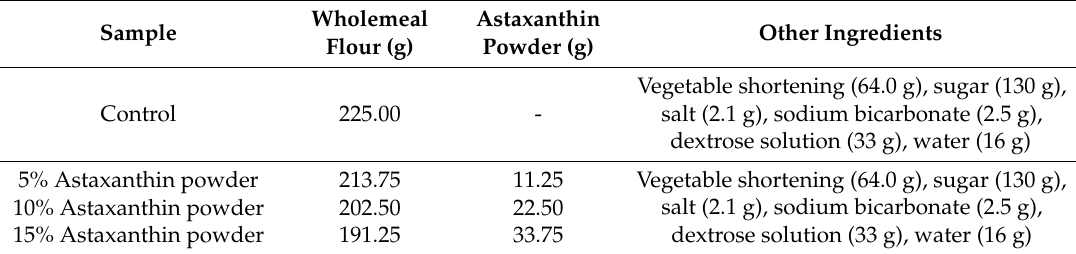
Table 1. Model food